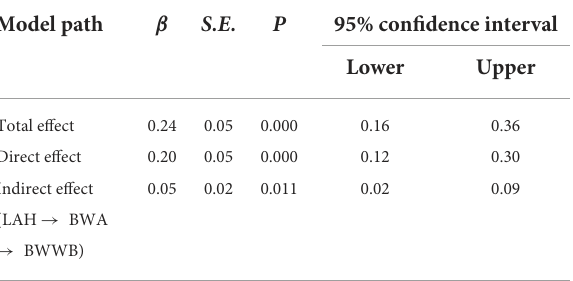
TABLE 4 Test results of mediation effect of bystander workplace anxiety.